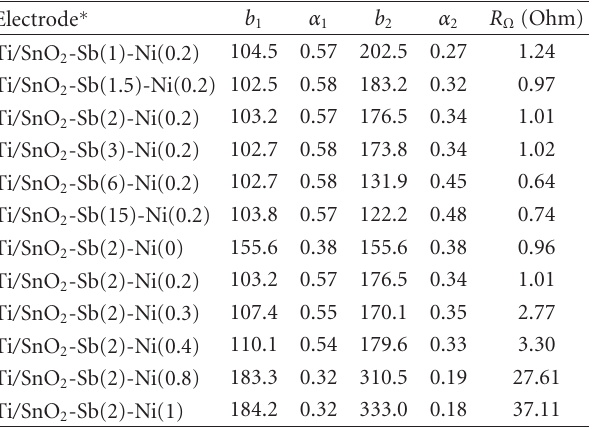
Table 1: Tafel slopes ( b ) and electronic transfer coe ffi cients ( α ) at low (subscript 1) and high (subscript 2) overpotential domains, and ohmic resistance of Ti/SnO 2 -Sb-Ni electrodes prepared with di ff erent Sb and Ni